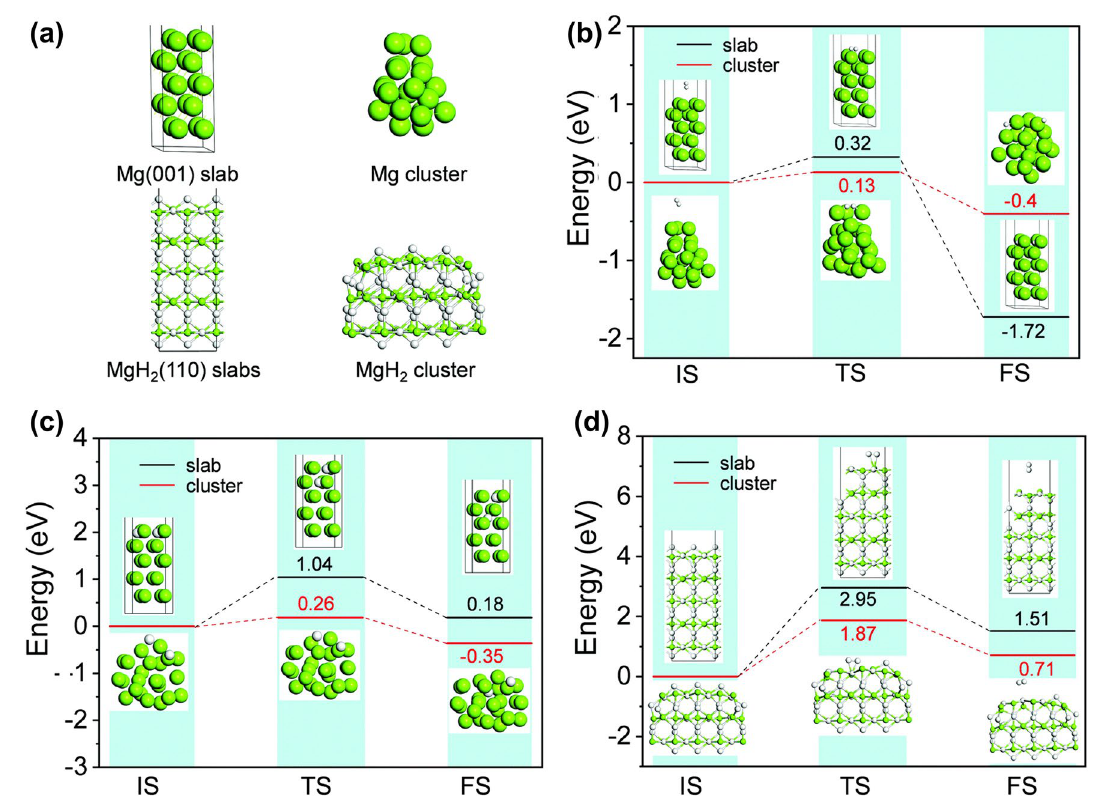
Fig. 5 a Computational structure models for bulk and nanosized Mg and MgH 2 . b Hydrogen uptake by Mg (001) slab and Mg cluster. c Diffu- sion energy barrier of H atoms in the Mg (001) slab and Mg cluster. d Hydrogen release from MgH 2 (110) slab and MgH 2 cluster. Reproduced with permission from Ref. [78]. Copyright 2021 Royal Society of Chemistry. (IS: initial state, TS: transition state, FS: final state. Mg: green. H: white). (Colour figure